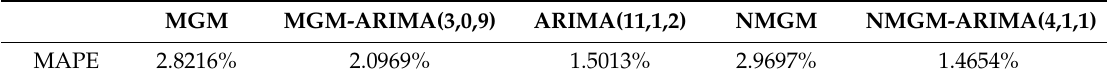
Table 14. Error of Five Models.